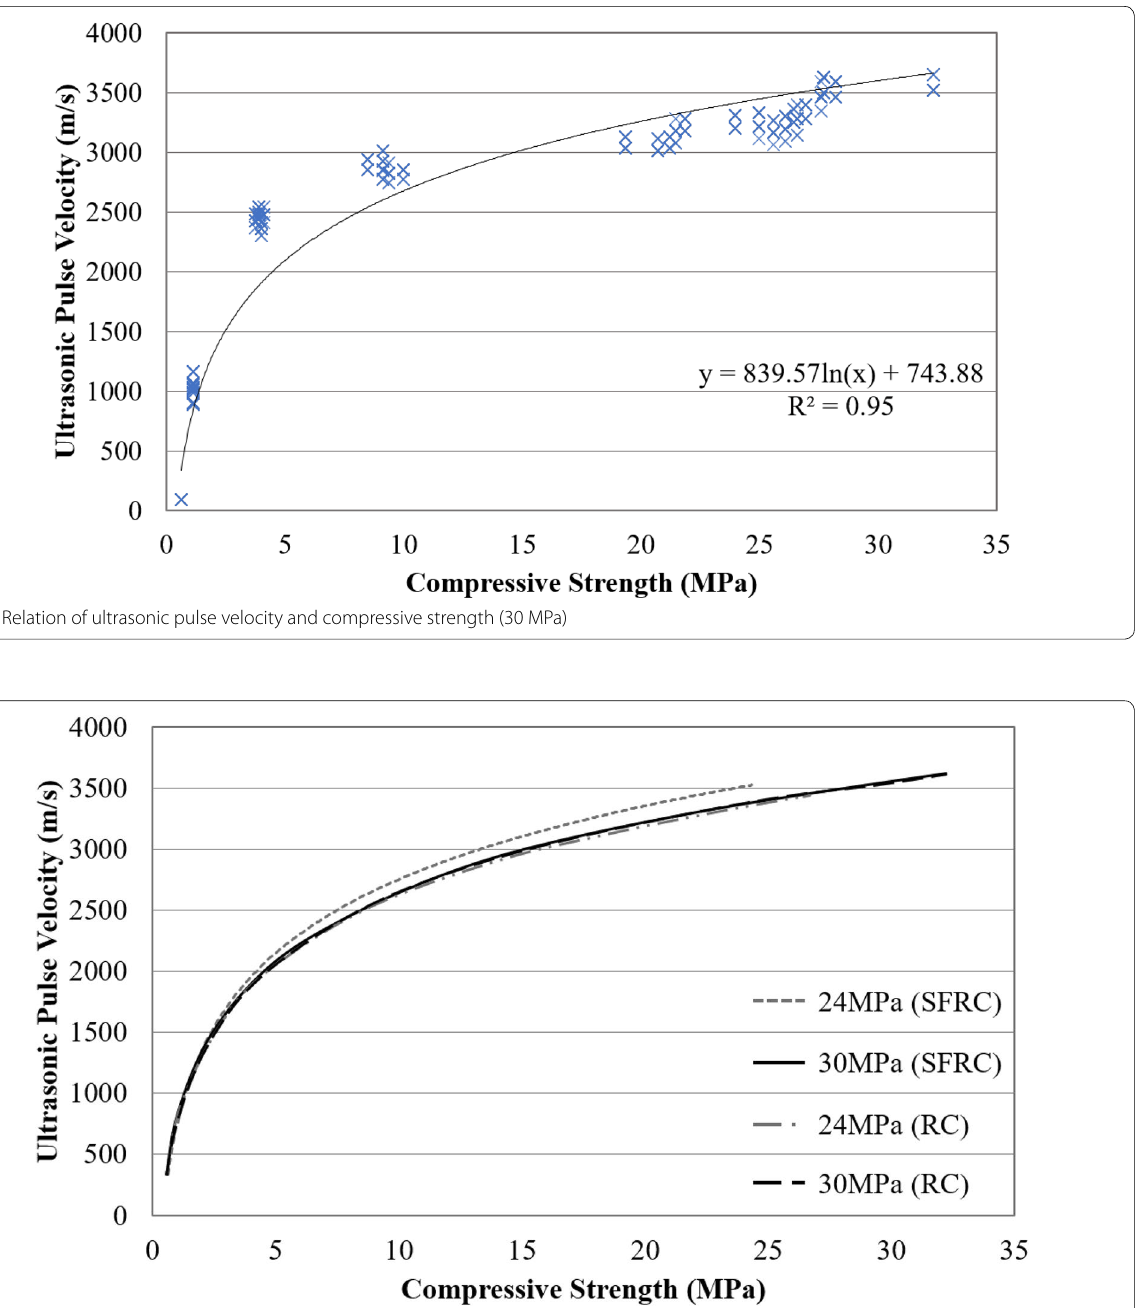
5 Experimental Program: Thickness Estimation of Steel Fiber Reinforced Concrete Experiments were conducted to estimate the member size by setting various thicknesses of the steel fiber rein- forced concrete using the nondestructive test method as shown in Fig. 8b.